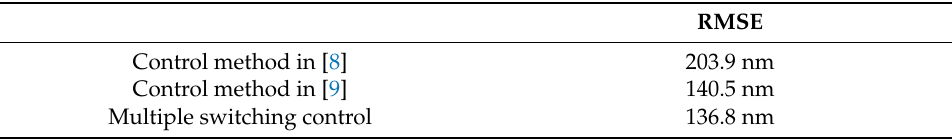
Figure 10. Experimental responses for tracking characters.: ( a ) character tracking; ( b ) x-axis responses; ( c ) zoom-in responses at the turning point around 332 sec; ( d ) zoom-in responses at the turning Table 4. Tracking performance of the combined stage. point around 564 sec. Table 4. Tracking performance of the combined stage.